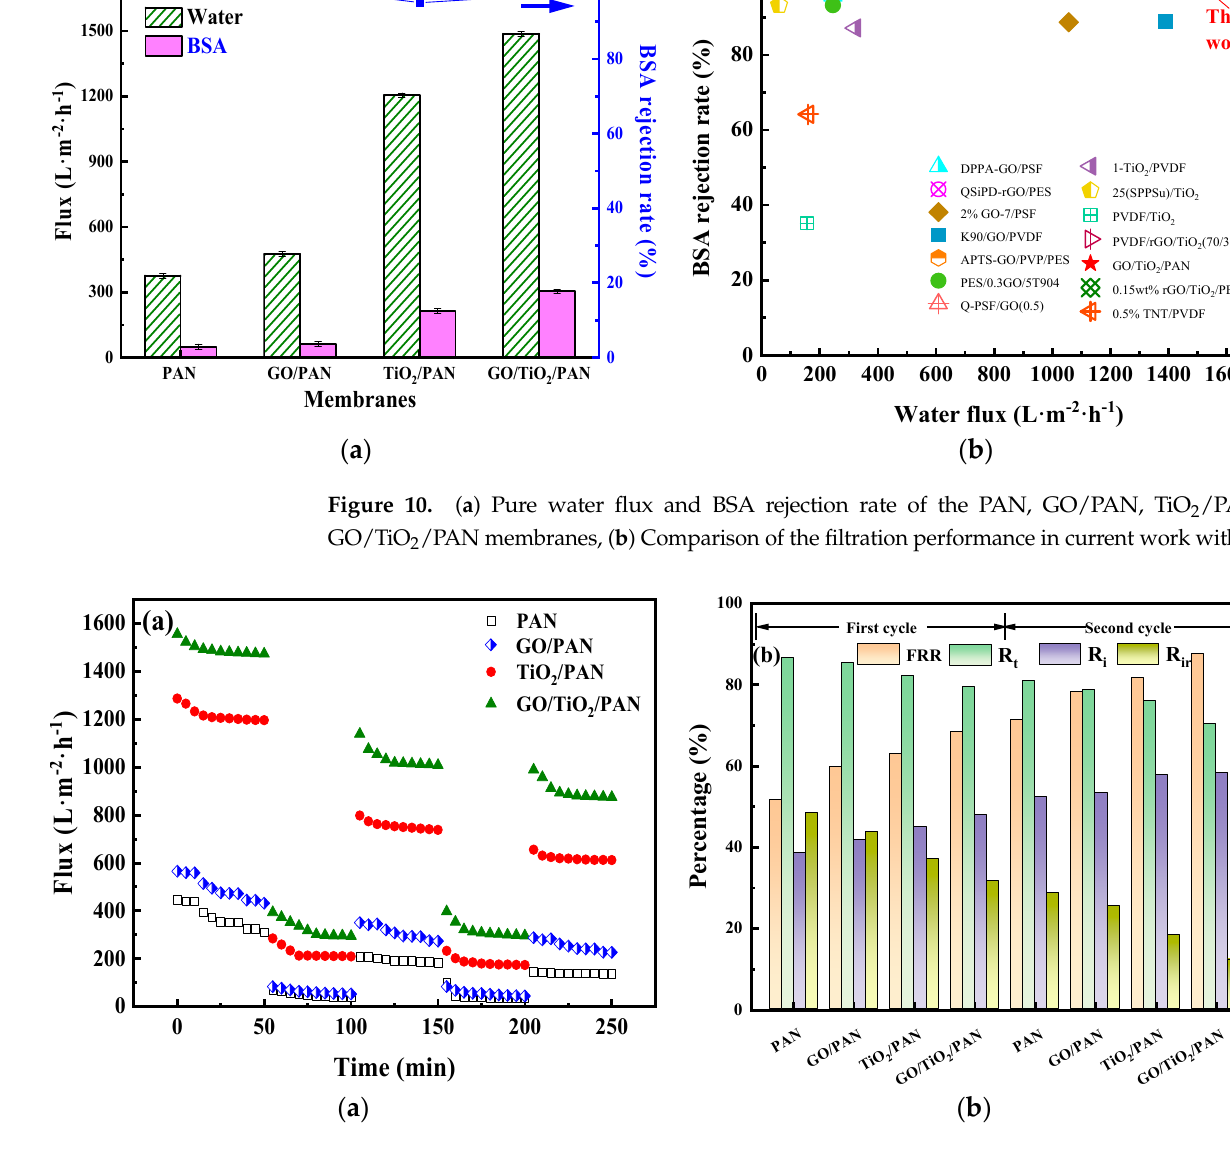
Figure 11. ( a ) Flux variations of the PAN, GO/PAN, TiO 2 /PAN, and GO/TiO 2 /PAN membranes during the three-step filtration cycles with two curves of the BSA results, ( b ) FRR, R i , R ir , and R t of the PAN, GO/PAN, TiO 2 /PAN, and GO/TiO 2 /PAN membranes in the two filtration circles. In Figure 10a, pure water fluxes of the MMMs were higher than those of the pure